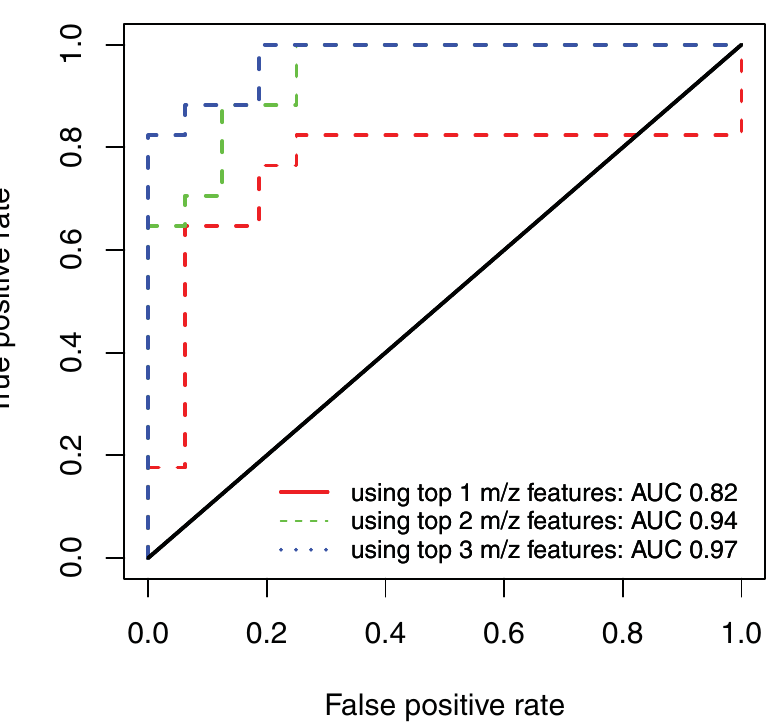
Fig 3. Receiver operating characteristic curve. M . tuberculosis lipid suspects phosphatidylglycerol (PG) (16:0_18:1), lysophosphatidylinositol (Lyso-PI) (18:0), and m/z 1321.9177 provided excellent classification accuracy for active TB disease [area under the curve (AUC) = 0.97], compared with PG (16:0_18:1) and Lyso-PI (18:0) (AUC = 0.94) or PG (16:0_18:1) alone (AUC = 0.82).